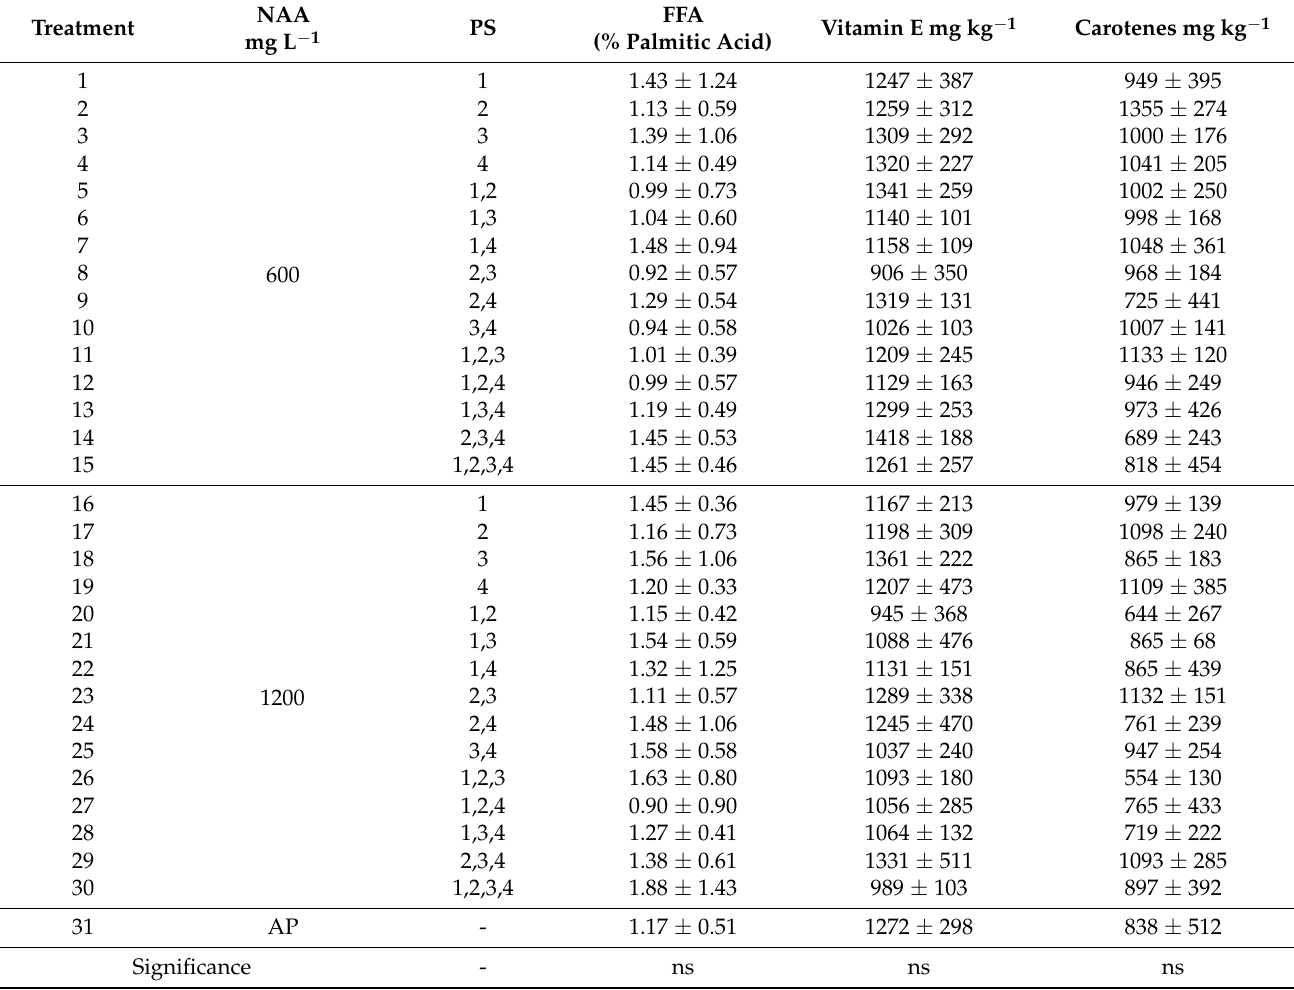
Table 7. Free fatty acids, Vitamin E, and carotene content in OxG hybrids (Coari x La M é ) treated with 600 mg L − 1 or 1200 mg L − 1 NAA for the induction of parthenocarpy. The NAA solutions were applied one, two, three, or four times at different phenological stages (603, 607, 609, 703). Assisted pollination treatment was performed only in inflorescences in anthesis (phenological stage